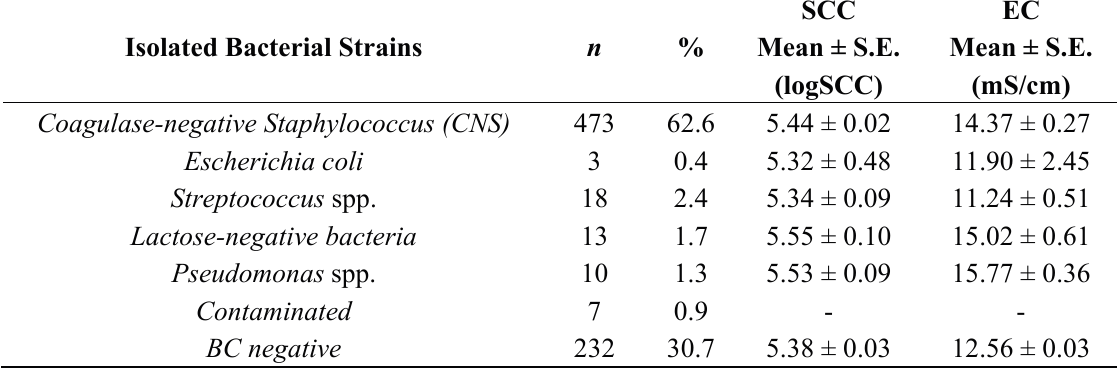
Table 2. Distribution of pathogenic microorganisms found in infected mammary glands. Overall means and standard errors, of SCC (log) and EC (mS/cm) of gland milk samples, according to each of the groups of pathogenic microorganisms found were also reported. Isolated Bacterial Strains